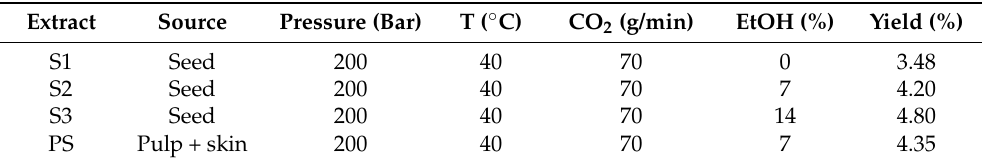
Table 1. Yield and conditions to obtain the supercritical extracts from the seed (S1, S2, and S3) and the pulp and skin (PS) from